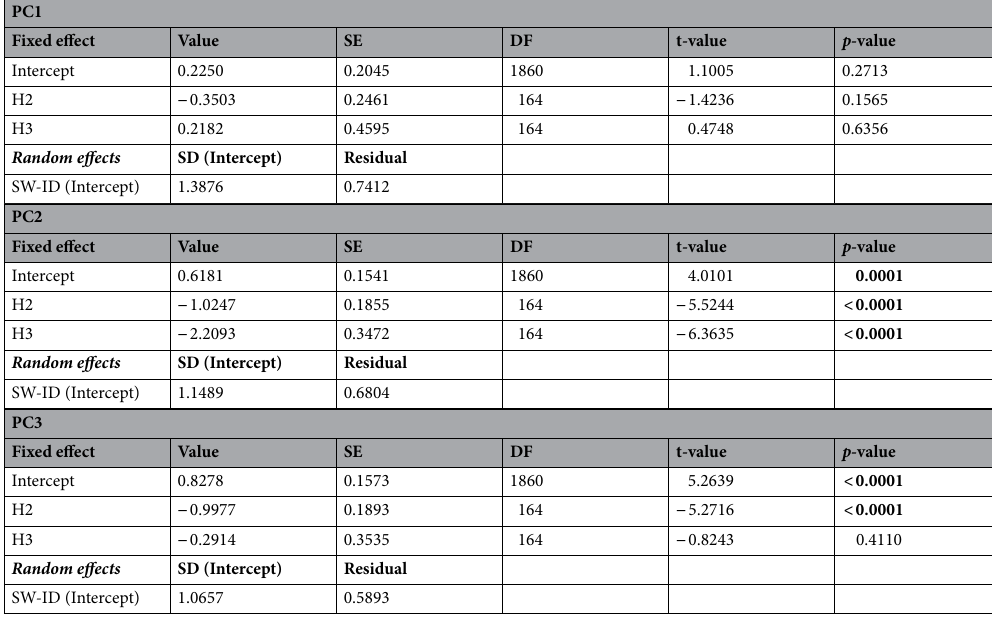
Table 3. Generalized linear mixed-effect model (GLMM) with ‘sea-bottom’ as explanatory variable on PC1, PC2 and PC3. The upper section shows the significant effects of the assessed explanatory variables. Value, standard errors (SE), t-values, and significance level ( p -value) for variables retained in the model are provided for fixed effects (explanatory variables), while estimates of the standard deviations (SD) are reported for random effects (SW-ID). Significant level in bold.